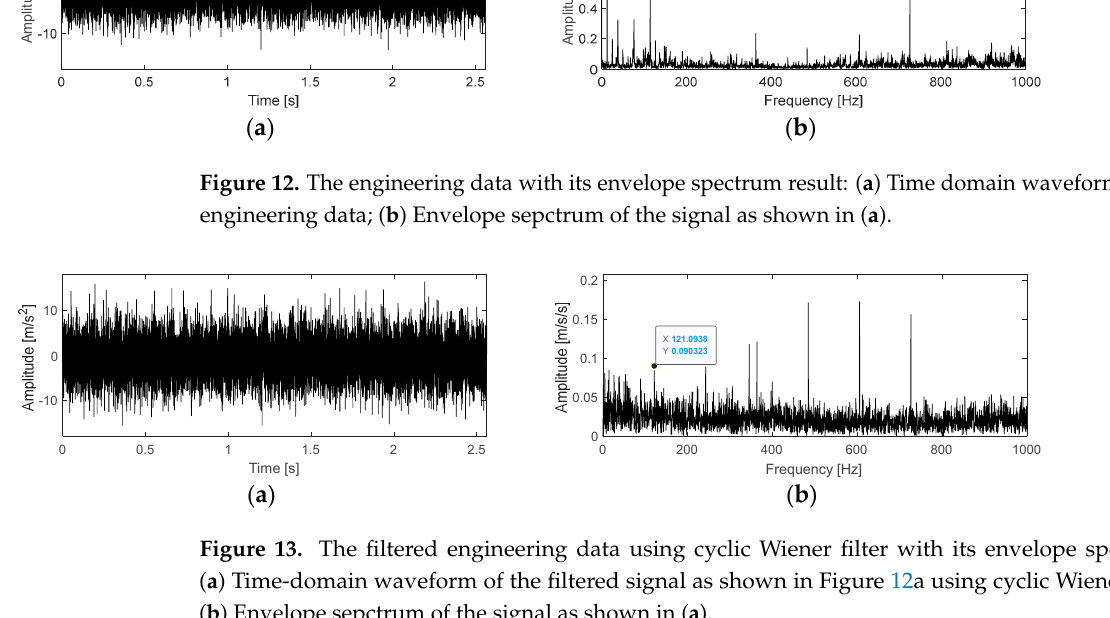
Figure 13. The filtered engineering data using cyclic Wiener filter with its envelope spectrum. ( a ) Time-domain waveform of the filtered signal as shown in Figure 12a using cyclic Wiener filter. ( b ) Envelope sepctrum of the signal as shown in ( a ).